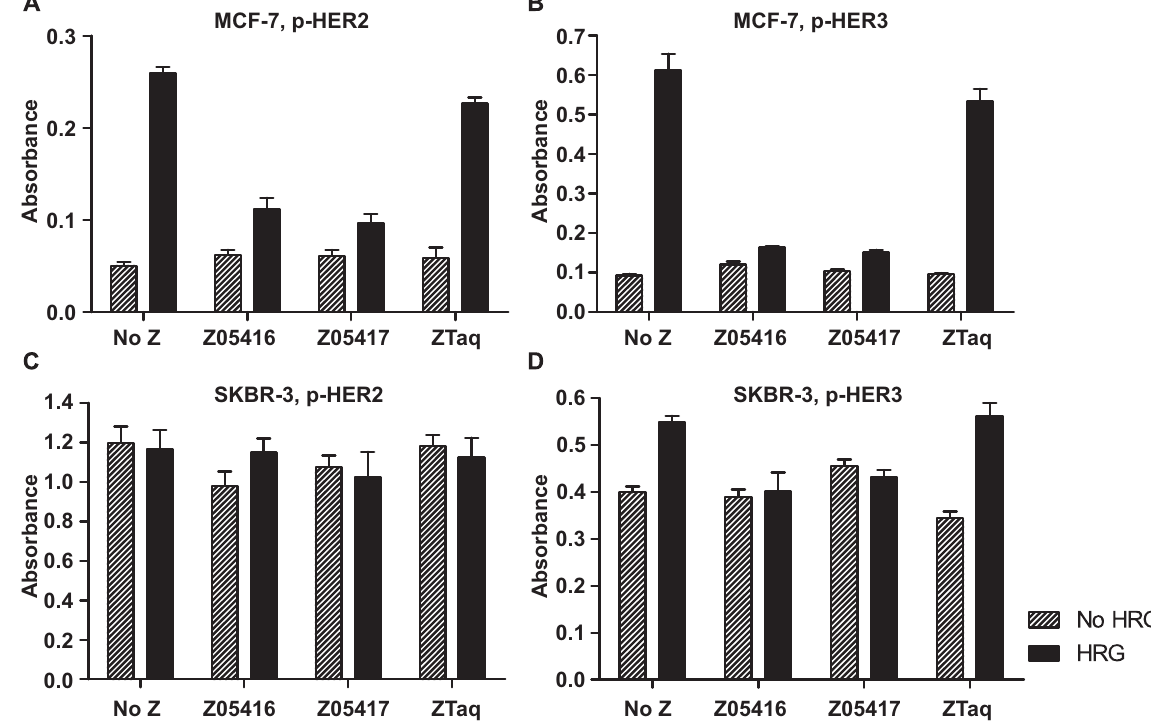
Figure 4. Analysis of receptor phosphorylation of MCF-7 and SKBR-3 cells. Histograms showing ELISA absorbance results for detection of: A. Phospho-HER2 in MCF-7 cells, B. Phospho-HER3 in MCF-7 cells, C. Phospho-HER2 in SKBR-3 cells and D. Phospho-HER3 in SKBR-3 cells. Cells were incubated without HRG (grey bars) or with 0.05 nM HRG (black bars), in combination with the Affibody molecules (100 nM) before being lysed and analysed in an ELISA.